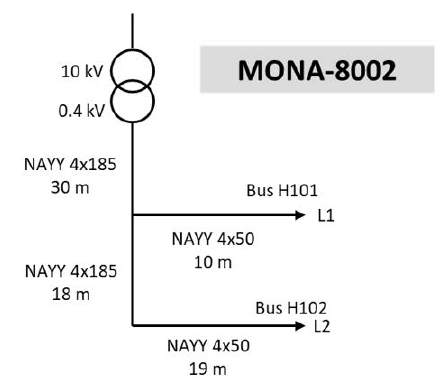
Figure A1. Single line diagram of MONA-8002 low voltage distribution grid